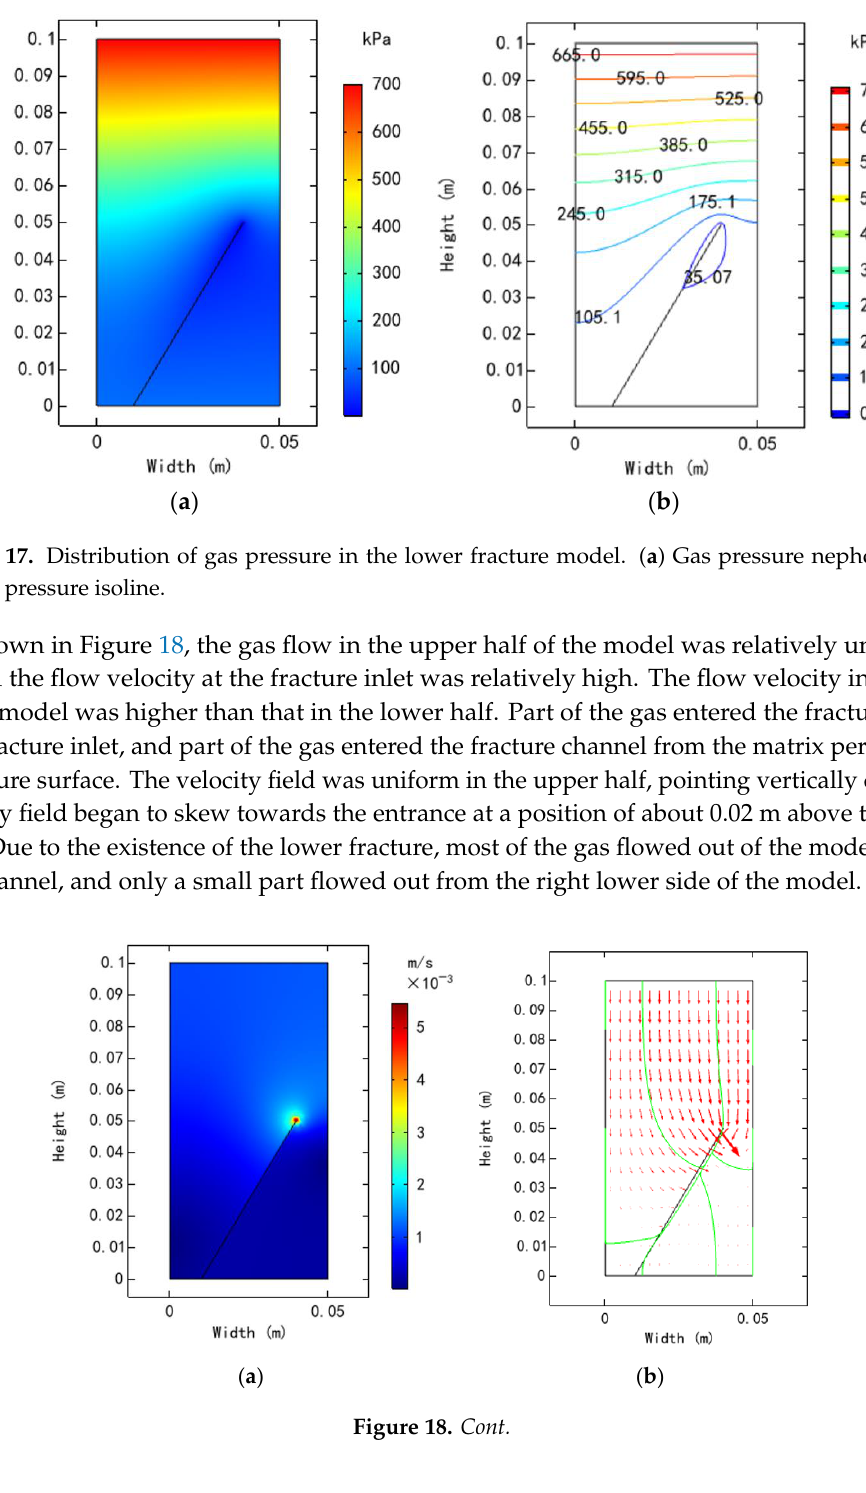
( d ) Figure 18. Distribution of gas velocity in the lower fracture model. ( a ) Gas velocity in the coal matrix; ( b ) gas velocity field in the coal matrix; ( c ) gas velocity in lower fracture; ( d ) gas velocity filed in lower fracture. 5.2.4. Parameter Analysis Transversal lines L 11 , L 21 , L 22 , and L 31 , were established at the fracture outlet of the upper fracture model, the fracture inlet and the fracture outlet of the middle fracture model, and the fracture inlet of the lower fracture model, respectively, as shown in Figure 19. The coordinates of the transversal lines were as follows: L 11 (0,0.06), (0.05,0.06); L 21 : (0,0.08), (0.05,0.08); L 22 : (0,0.04), (0.05,0.04); L 31 : (0,0.08), (0.05,0.08). The velocity and the pressure along the transversal lines are shown in Figure 20.